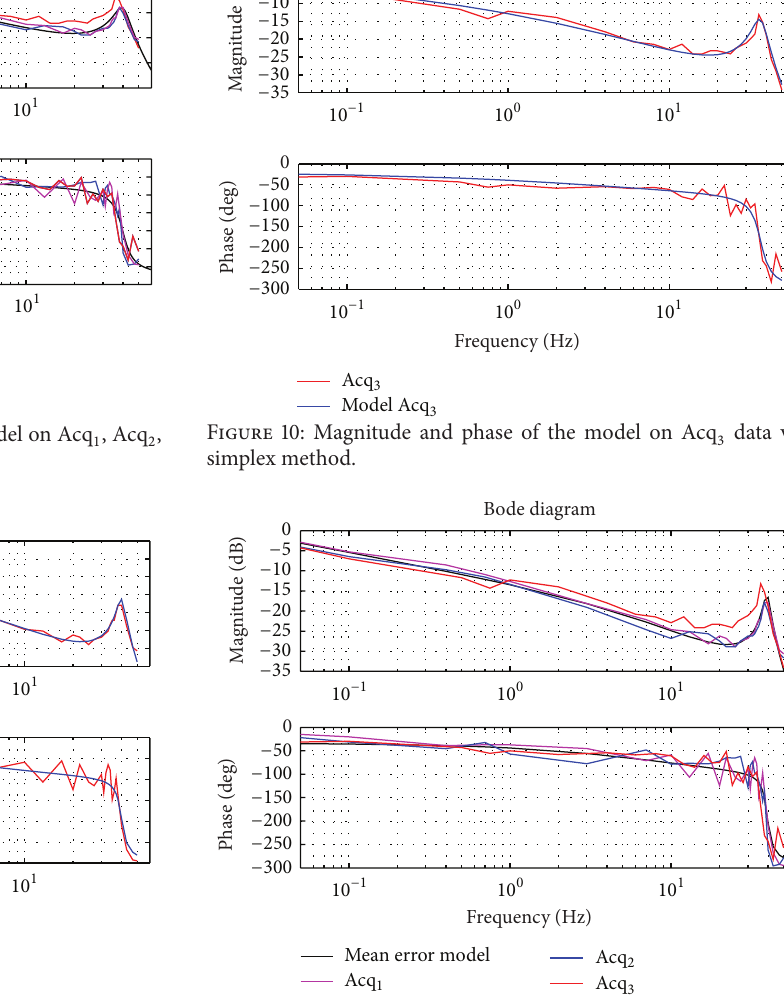
Figure 8: Magnitude and phase of the model on Acq 1 data via simplex method.